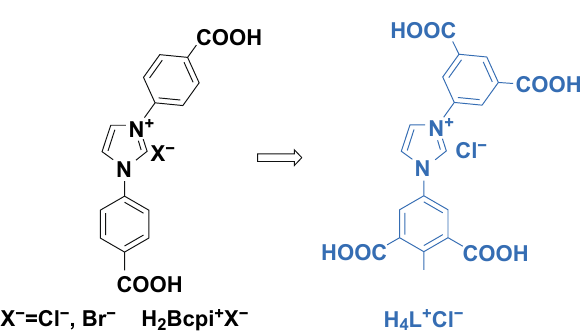
Fig. 9 Modification of H 2 Bcpi + X – for H 4 L + Cl – . Reprinted with per- mission from Ref. [41]. Copyright 2019, American Chemical